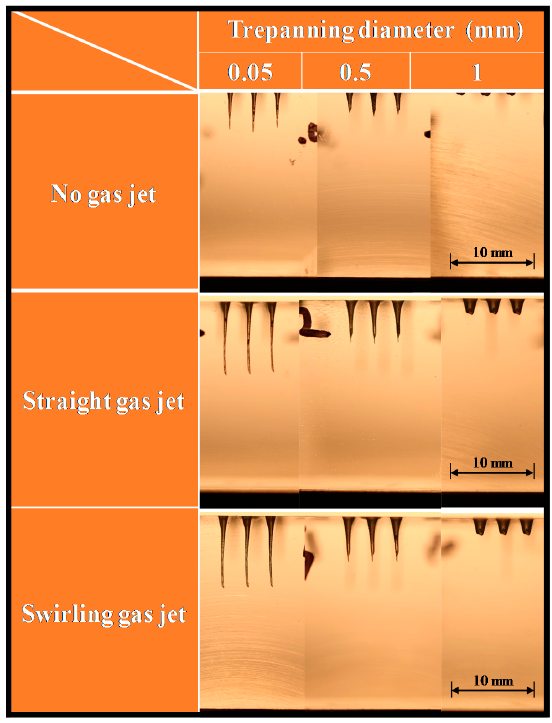
Figure 14. Profile images of drilled holes with different gas jet configurations (no gas jet, swirling gas jet, and straight gas jet) at different trepanning diameters.